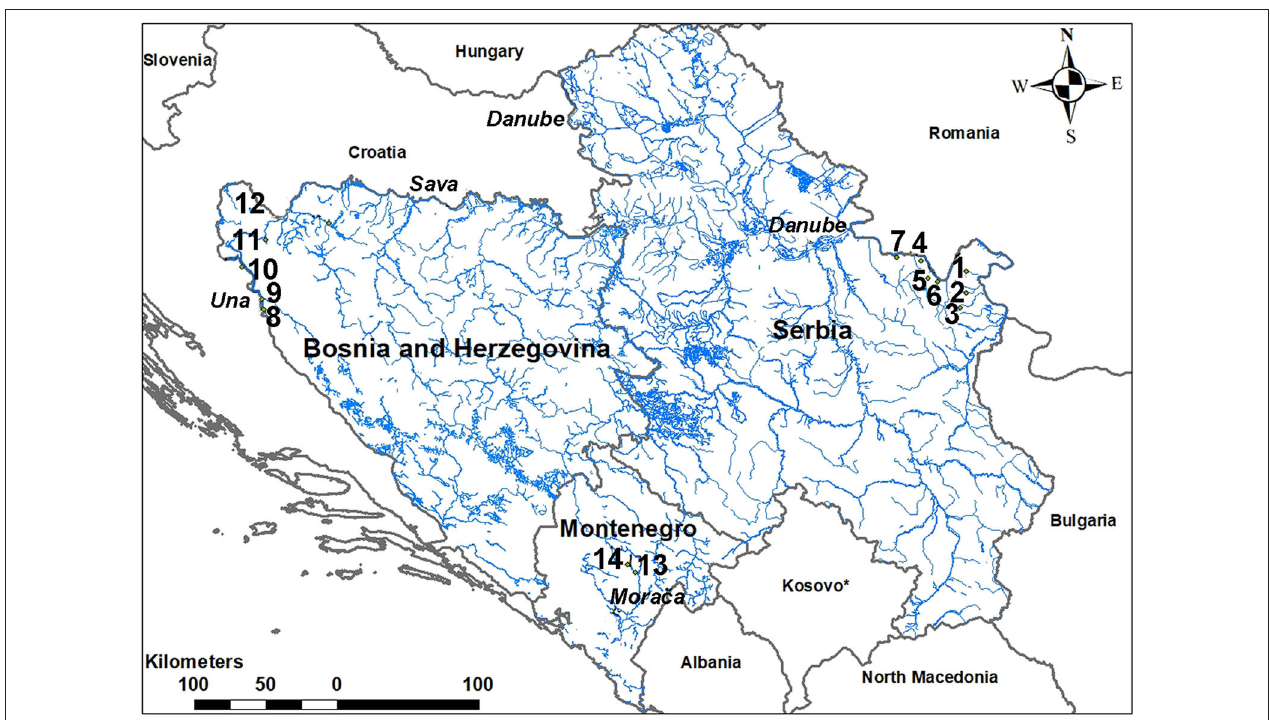
FIGURE 1 | Map of the study area in the Western Balkans where brown trout populations were sampled (1. Zamna River; 2. Re ˇ cka River; 3. Vratna River; 4. KoŽica River; 5. Mala Boljetinska River; 6. Zlatica River; 7. Brnjica River; 8. Krka River; 9. Upper Una River at Martinbrod; 10. Upper Una River at Loskun; 11. Svetinja River; 12. Krušnica River; 13. lower Mrtvica River; 14. upper Mrtvica